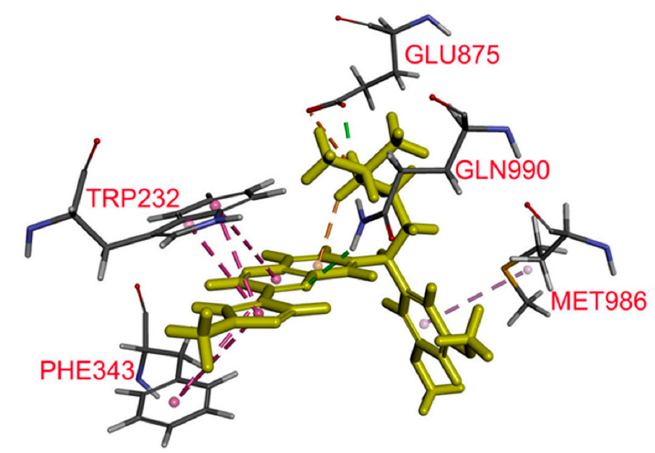
Figure 6. Docking of erdafitinib in the drug-binding pocket of ABCB1. Binding modes of erdafitinib with ABCB1 protein structure (PDB: 6QEX) was predicted by BIOVIA (Accelrys) Discovery Studio 4.0 software (San Diego, CA, USA) as described in the Materials and Methods. Erdafitinib is shown as a molecular model with the highlighted yellow color and the atoms for interacting amino acid residues are colored as carbon, gray; hydrogen, light gray; nitrogen, blue; and oxygen, red. Dotted lines indicate proposed